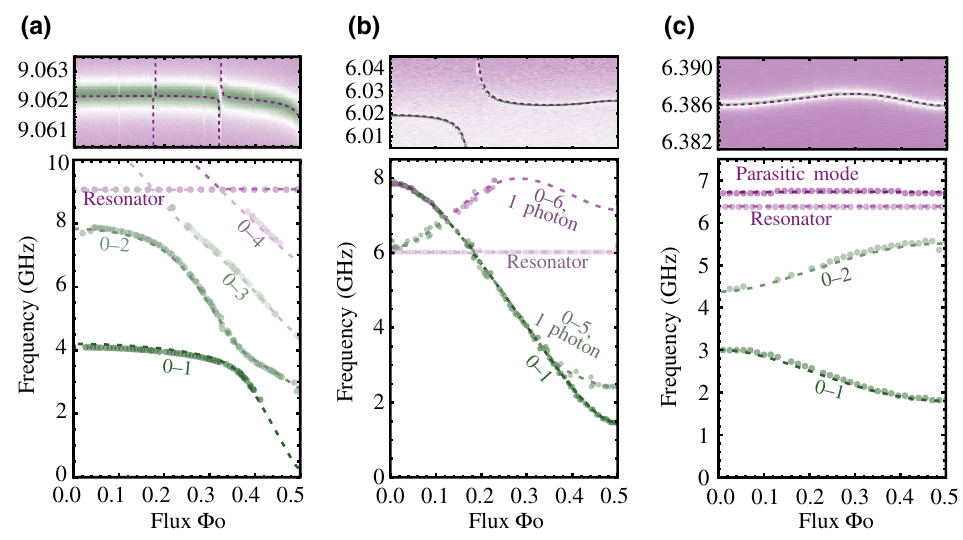
FIG. 3. Flux-dependent qubit and resonator spectra. The measured resonator reflection amplitude (top, color scale) and two-tone spectroscopy (bottom, dots) of three representative qubits as a function of the flux in (a) a flux qubit (G), (b) a fluxonium qubit (C), and (c) a quasicharge qubit (F). The dotted lines are fits to the diagonalized spectrum of the full-system Hamiltonian given by Eq. (2). Only in the case of the quasicharge qubit in (c) is the qubit coil parasitic mode lowered significantly, due to a very large coil inductance and capacitance; this becomes visible in the spectroscopy measurement at 6.7 GHz. A quantitative model of the parasitic mode is presented in Appendix B.